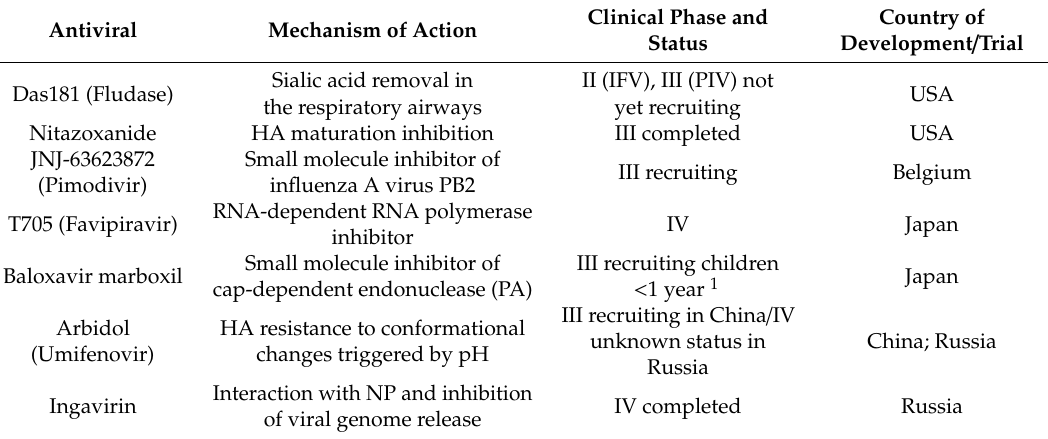
Table 2. Influenza antiviral drugs approved or in clinical